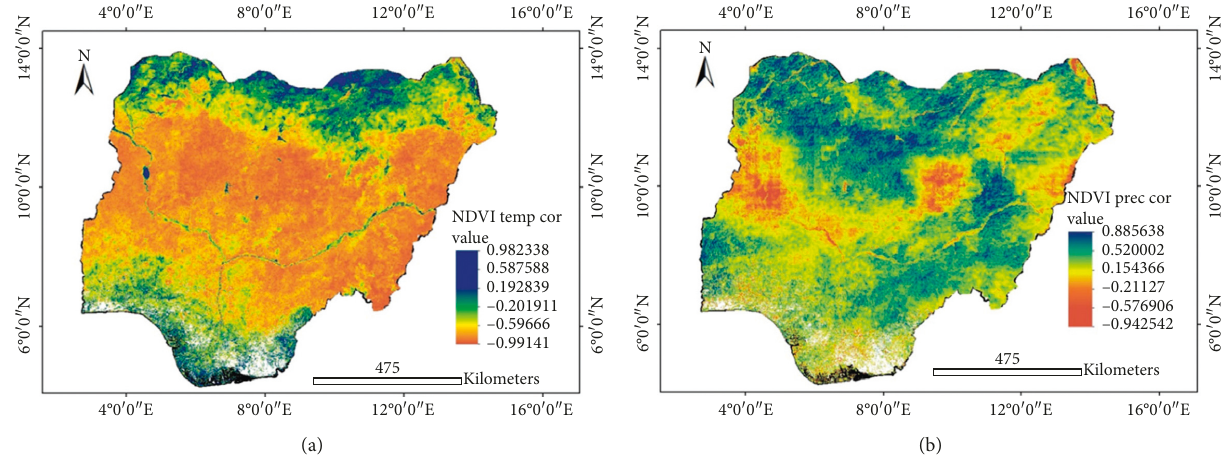
Figure 7: Correlation between NDVI and (a) mean temperature and (b)